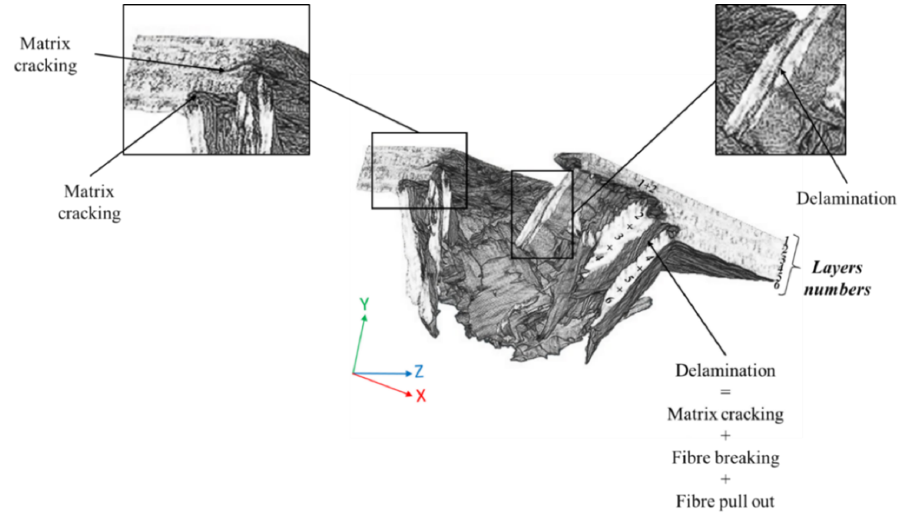
Figure 15. Micro CT scan picture of a flax composite specimen (3/4 of the impact hole) after an impact test, with a 50 J impact energy, showing different failure modes in the specimen.